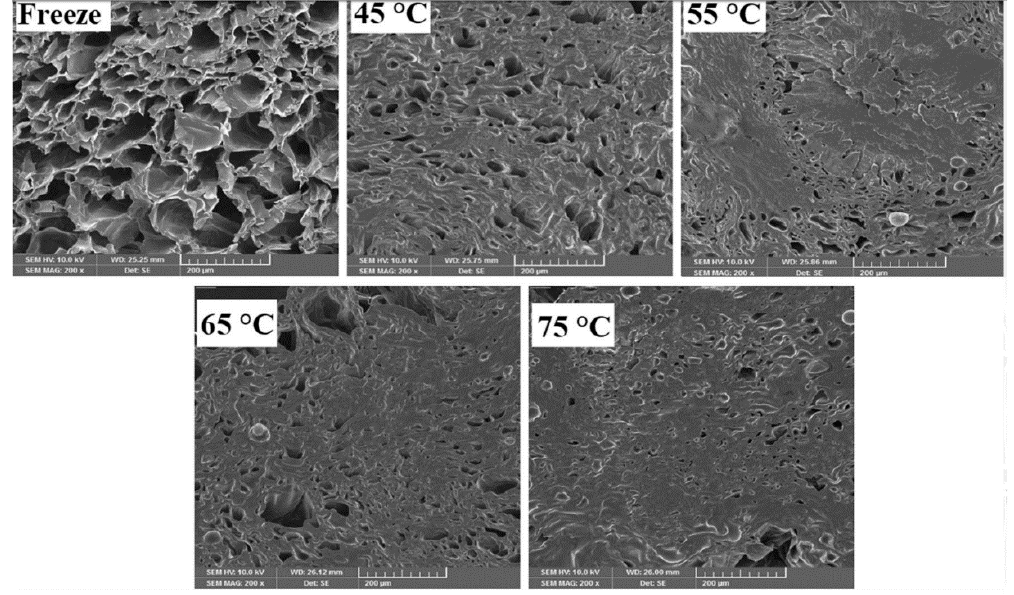
Figure 2. Micrographs of quince fruits during freeze and convective drying. Source; Izli and Polat [60].